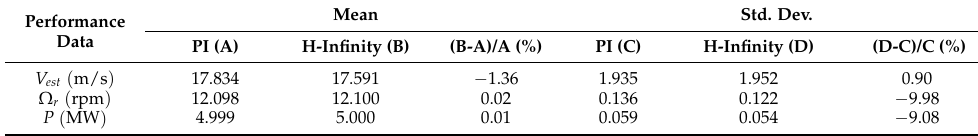
Table 3. Comparison of NTM results for performance data in 18 m/s noiseless environment.